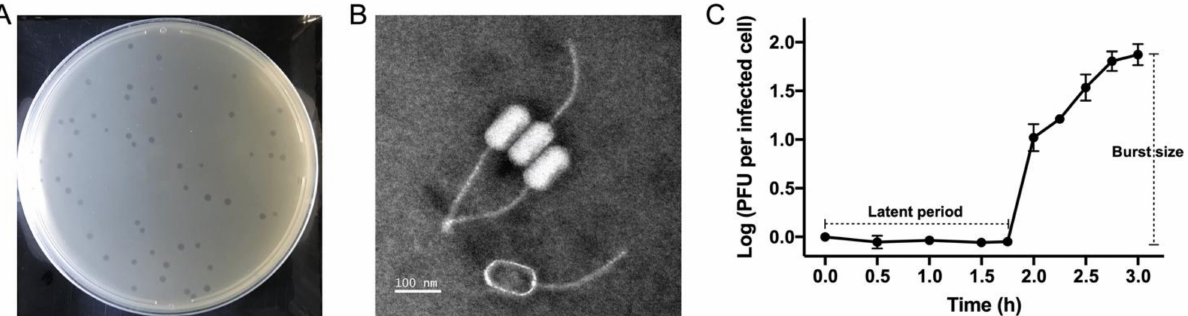
Figure 1. ( A ) Plaques of RXM formed on the bacterial lawn of C. bathyomarinum JL1366 after 24 hours of incubation. As a reference, the diameter of the culture dish was 90 mm. ( B ) TEM image of RXM. Scale bar, 100 nm. The phage characterized by the empty capsid structure indicates a lack of DNA, which is probably due to the damage during sample preparation. ( C ) One-step growth curve of phage RXM and each data point is shown as the mean ± SD of three independent